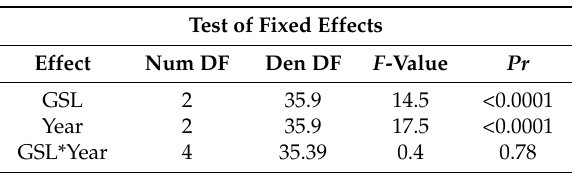
Table A1. ANOVA table for mountain pine beetle flight across stands of different Growing Stock Levels (GSL).